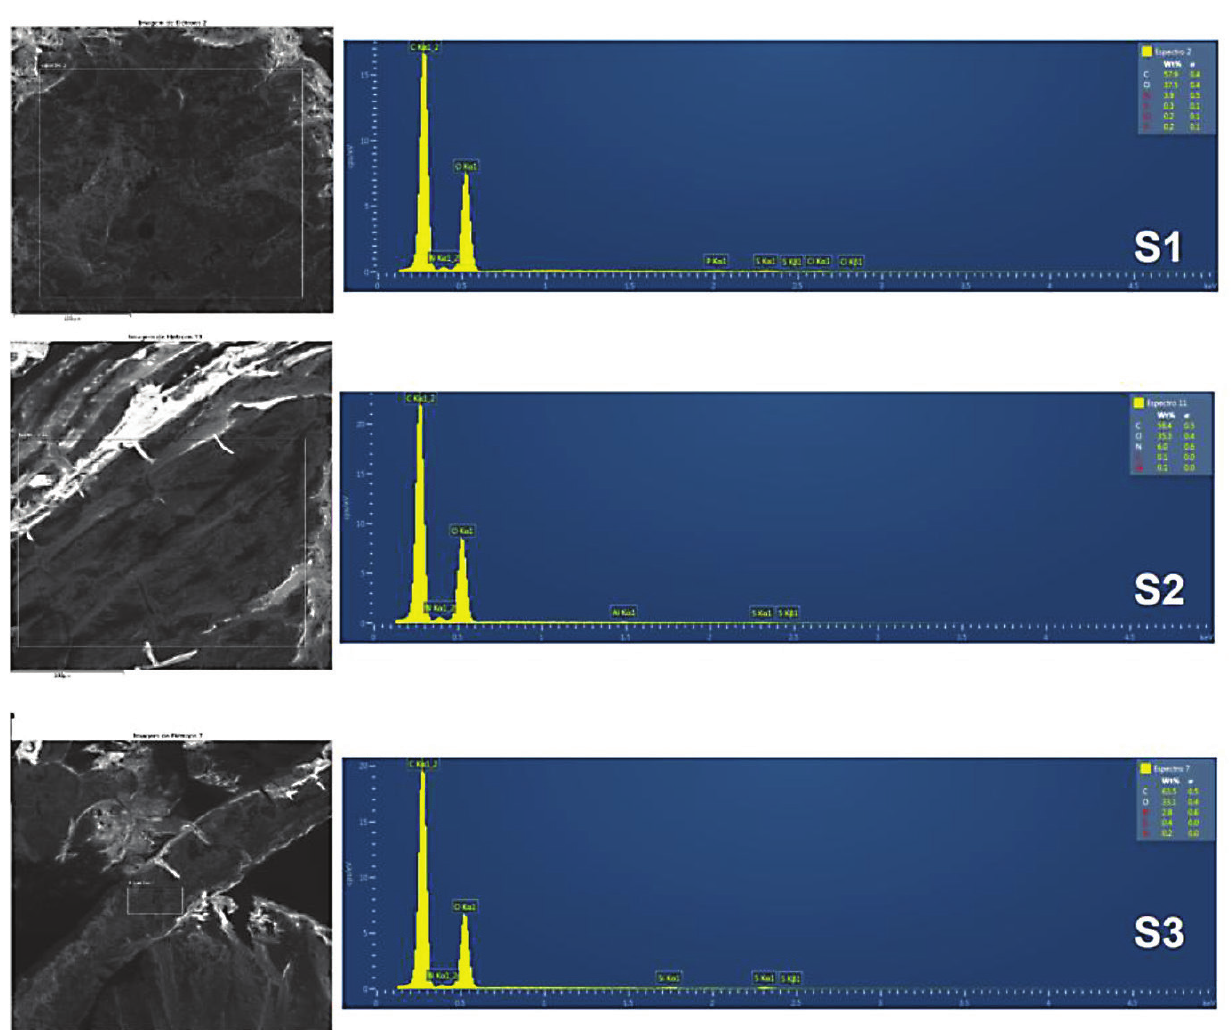
Fig. 2 – EDS (energy dispersive X-ray analysis) after adsorption of the dye on Açaí seeds (where S1, S2 and S3 are the three dif- ferent structures of the